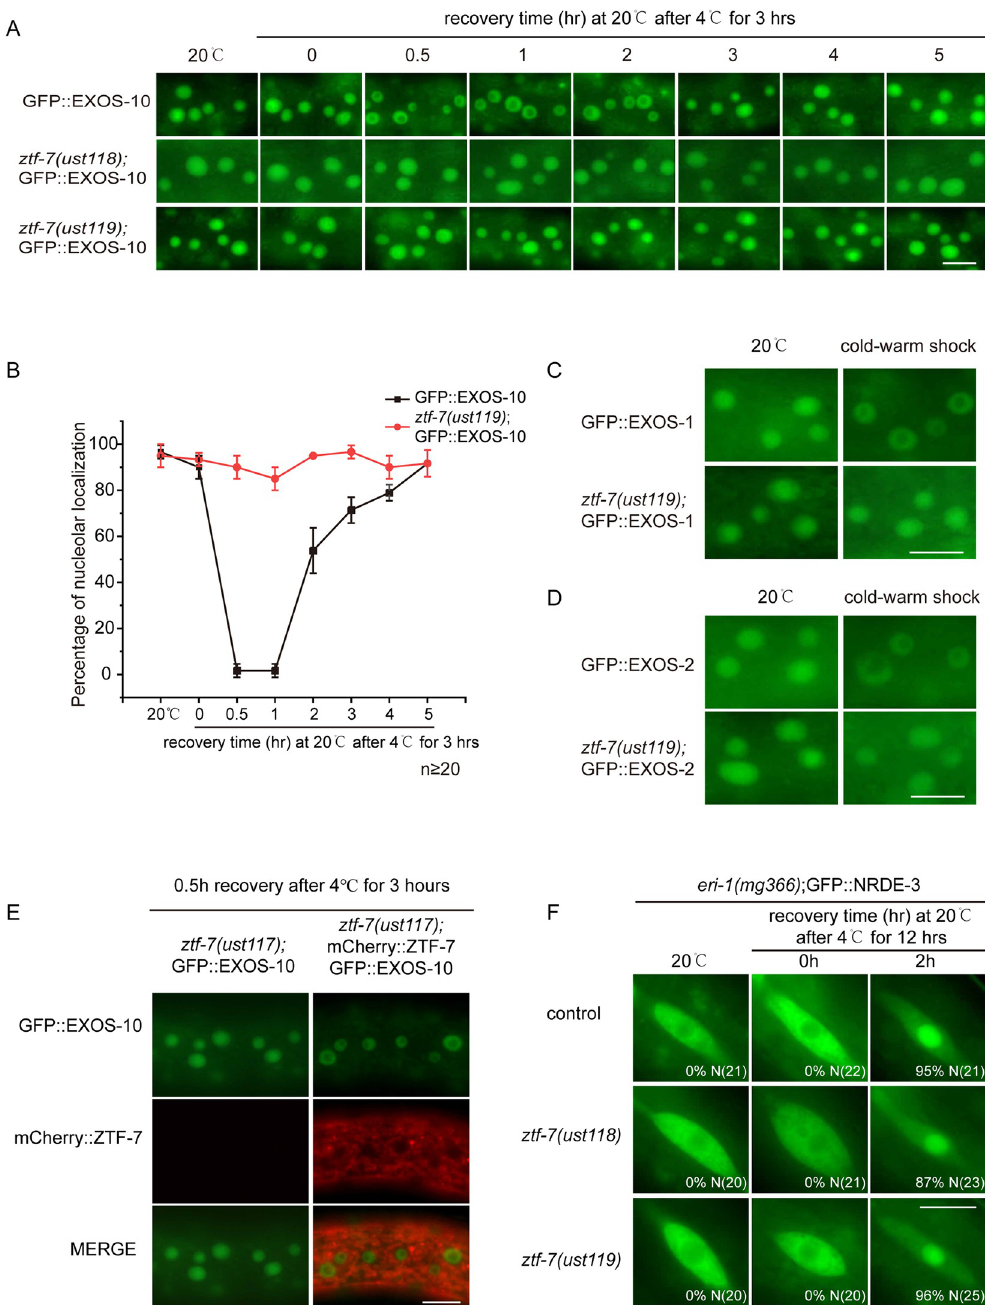
Fig 4. ZTF-7 is specifically required for cold-warm shock-induced exosome translocation. (A) Images of the localization of EXOS-10 at 20˚C and after cold-warm shock at 4˚C for 3 hours followed by recovery at 20˚C for different times. Images were taken from epidermal cells. Scale bars, 10 μ m. (B) The curve graph represents the percentage of animals with nucleolus- enriched EXOS-10 in epidermal cells after 4˚C for 3 hours. n � 20 animals. (C, D) Images of the localization of EXOS-1 (C) and EXOS-2 (D) at 20˚C and after 4˚C for 3 hours followed by recovery at 20˚C for 0.5 hour. Scale bars, 10 μ m. (E) Images of epidermal cells of ztf-7(ust117);gfp :: exos-10;mCherry :: ztf-7 animals at L3/L4 stage. mCherry :: ztf-7 rescued the cold-warm shock-induced translocation of GFP::EXOS-10 in ztf-7(ust117) animals. Scale bars, 10 μ m. (F) Images show seam cells of the indicated L4 stage animals expressing GFP::NRDE-3. Numbers indicate the percentage of animals with nucleus-enriched NRDE-3 in seam cells (% N). The number of scored animals is indicated in parentheses. Scale bars, 10 μ m. Worms were treated at 4˚C for 12 hours and then grown at 20˚C for 2 h, followed by counting and